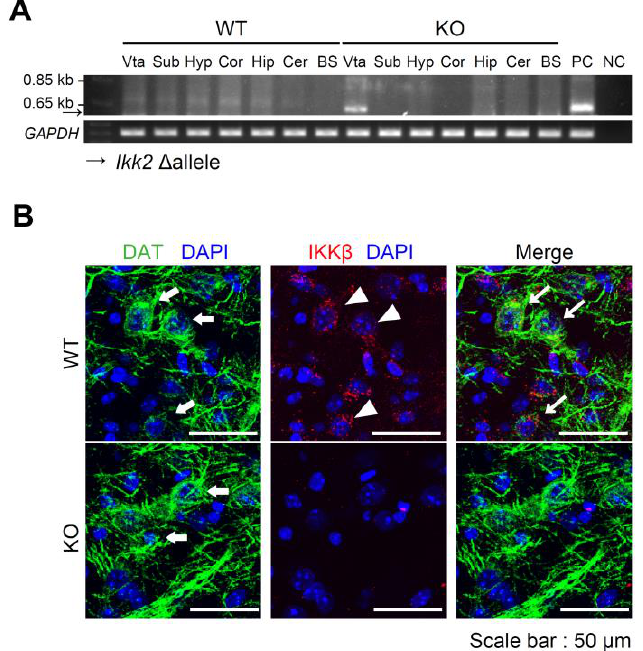
Figure 1. Generation of dopaminergic neuron-specific IKK β deficient mice. ( A ) Detection of deleted IKK2 alleles ( ∆ ) in IKK β lox/lox DAT-Cre (KO) mice. DNA was extracted from different tissues as follows, ventral tegmental area (Vta); substantia nigra (Sub); hypothalamus (Hyp); cerebral cortex (Cor); hippocampus (Hip); cerebellum (Cer); brain stem (BS); positive control (PC); negative control (NC). The deletion of the floxed allele was detected by PCR. GAPDH was used as an internal control. ( B ) Representative pictures showing DAT (green), IKKβ (red), and DAPI (blue) staining in the VTA of WT and KO mice. White thick arrow heads indicate co-localization of DAT and DAPI; white triangles indicate co-localization of IKK β and DAPI; white thin arrow heads indicate co-localization of DAT, DAPI and IKKβ.